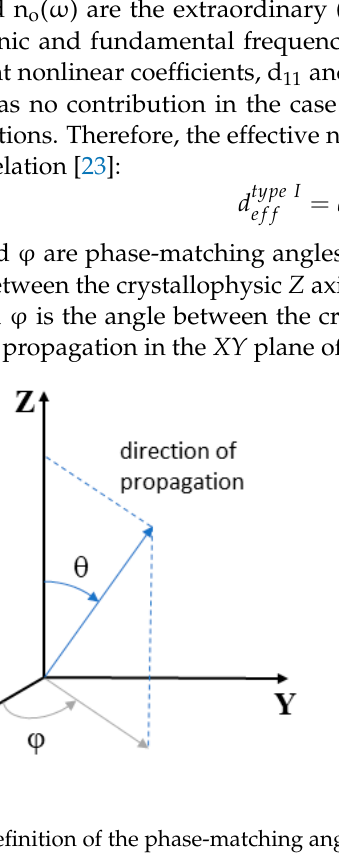
Table 5. NLO properties of the Czochralski ‐ grown LYSB crystal for type ‐ I SHG of 1064 nm funda ‐ mental wavelength. (Adapted with permission from ref. [13], copyright 2019 American Chemical Society).